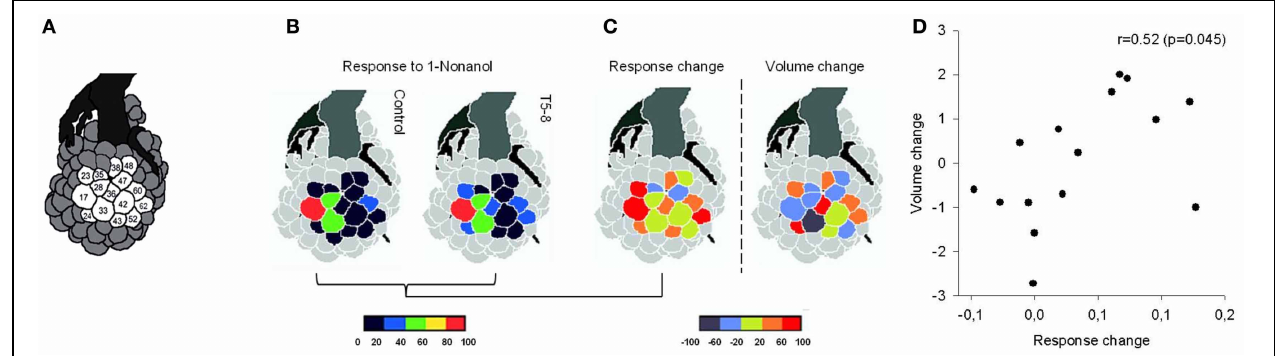
FIGURE 3 | Morphological and functional glomerular plasticity in 15 identified glomeruli of the honeybee antennal lobe (AL). (A) Schematic representation of the honeybee antennal lobe (AL) showing the 15 identified glomeruli of the AL labeled with their numbers. (B) Glomerular maps of calcium activity in response to 1-Nonanol in 17-day-old control bees (left) and in T5–8 bees (right), that were offered scented food 5–8 days after emergence. (C) Change in odor-evoked activity after early olfactory